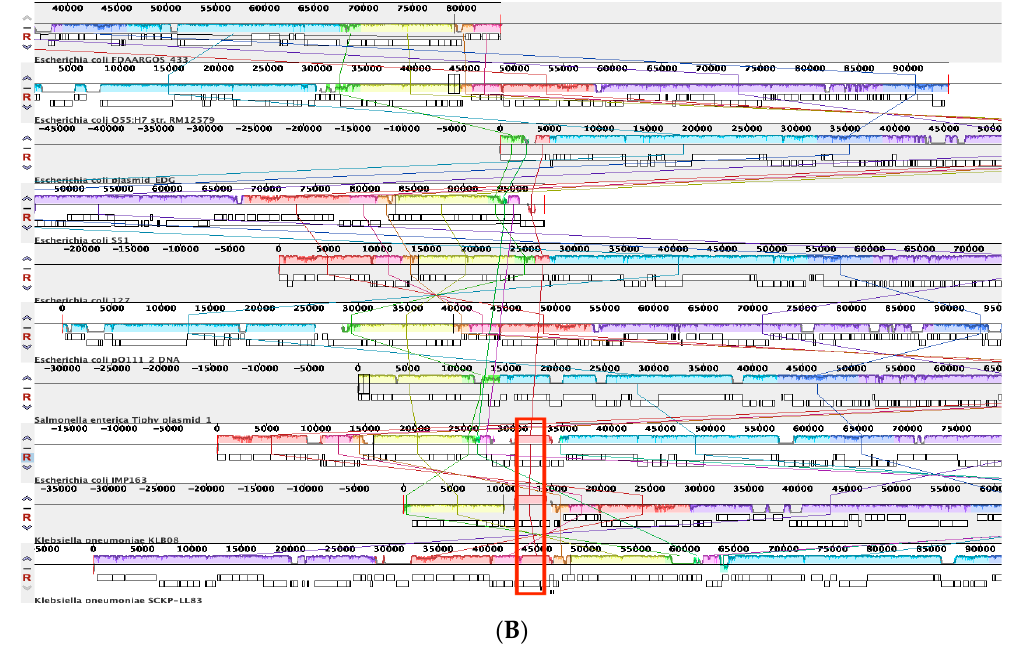
Figure 3. Physical map of a global alignment of phage-like plasmids against pBOq-95LK with MAUVE. ( A ) Alignment of plasmids centering at the position of bleomycin hydrolase (red rectangle). ( B ) Alignment of plasmids centering at the position of mcr -1 gene (red rectangle) present in only three plasmids.